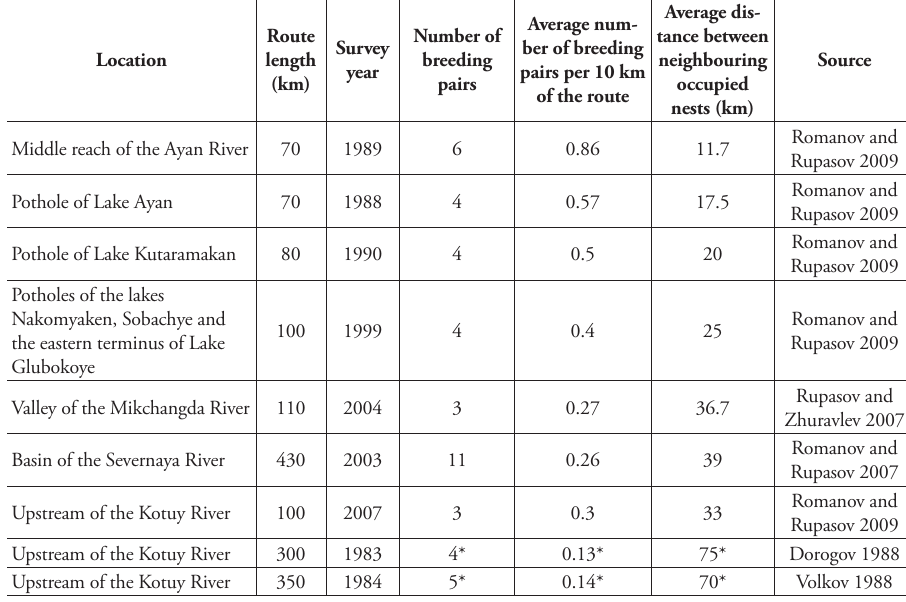
Average dis- tance